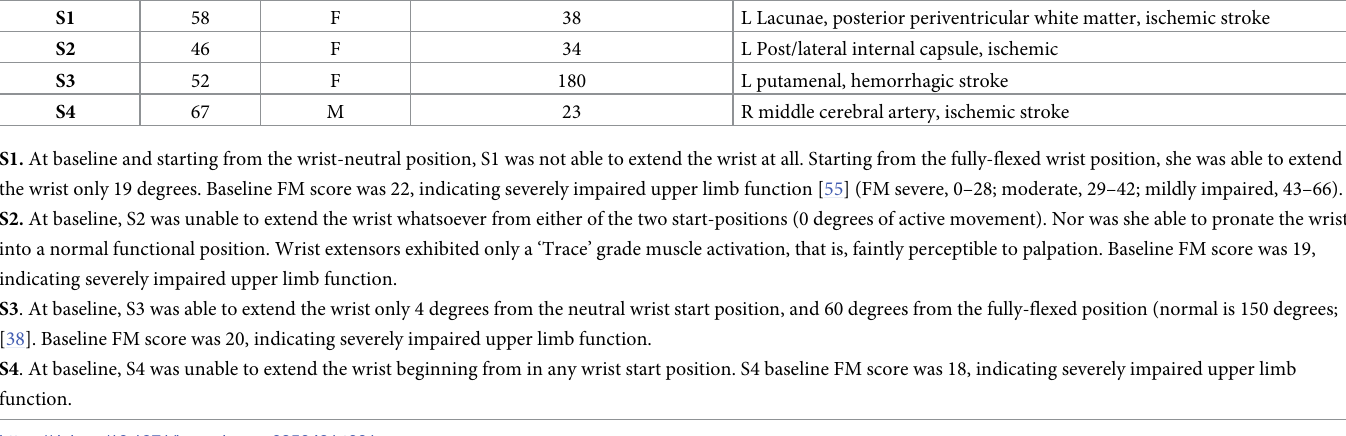
consistent with that provided during rt-fMRI, described above, with two exceptions. First, updates to the visual feedback occurred once per second rt-fNIRS. Second, the stroke survivor received FES-assisted movement that was triggered each time the brain signal was at or above the custom-derived threshold.